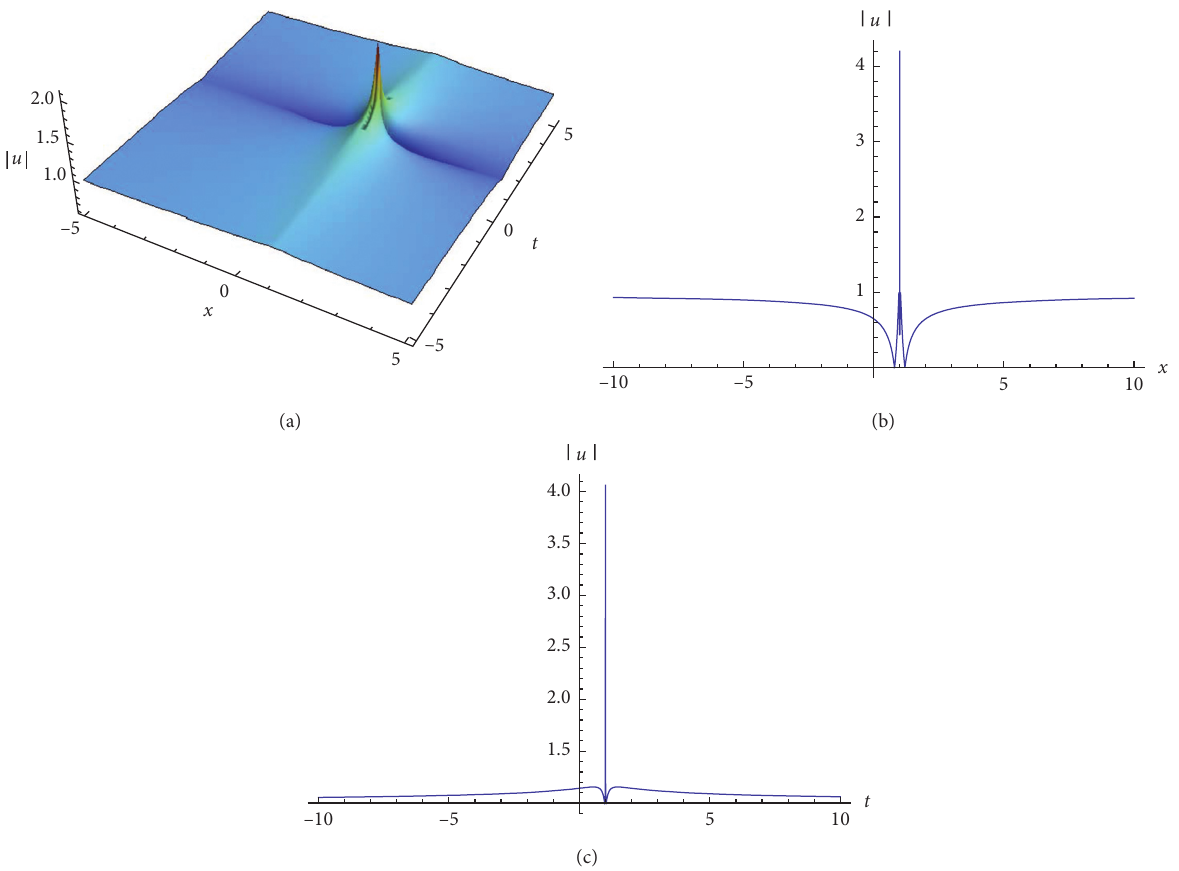
Figure 10: Second-order fractional rogue wave solution (color online) (39) with α � 1/3 and a � 1.